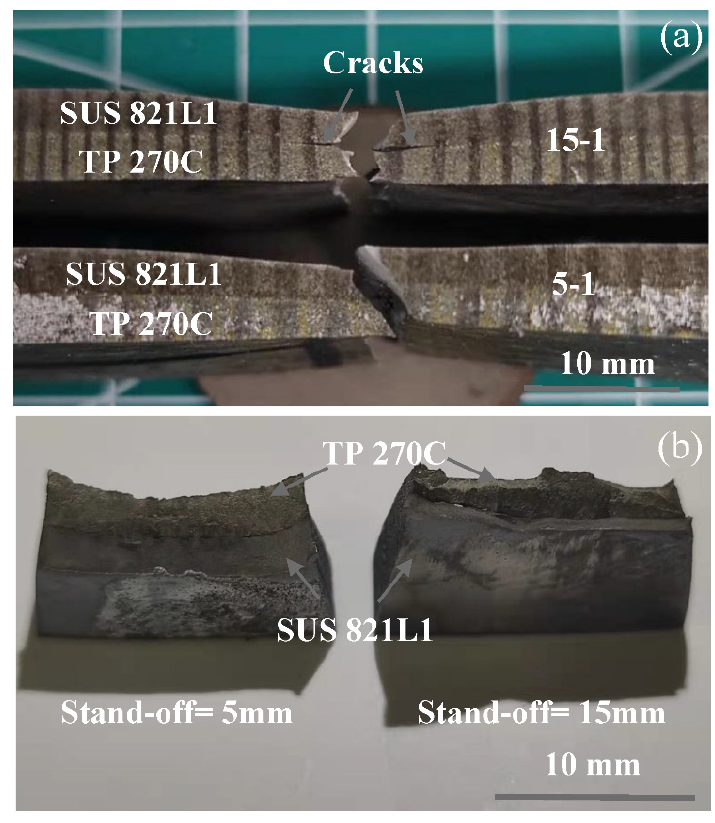
Figure 6. Macro-fracture: ( a ) Side view; ( b ) Top view.